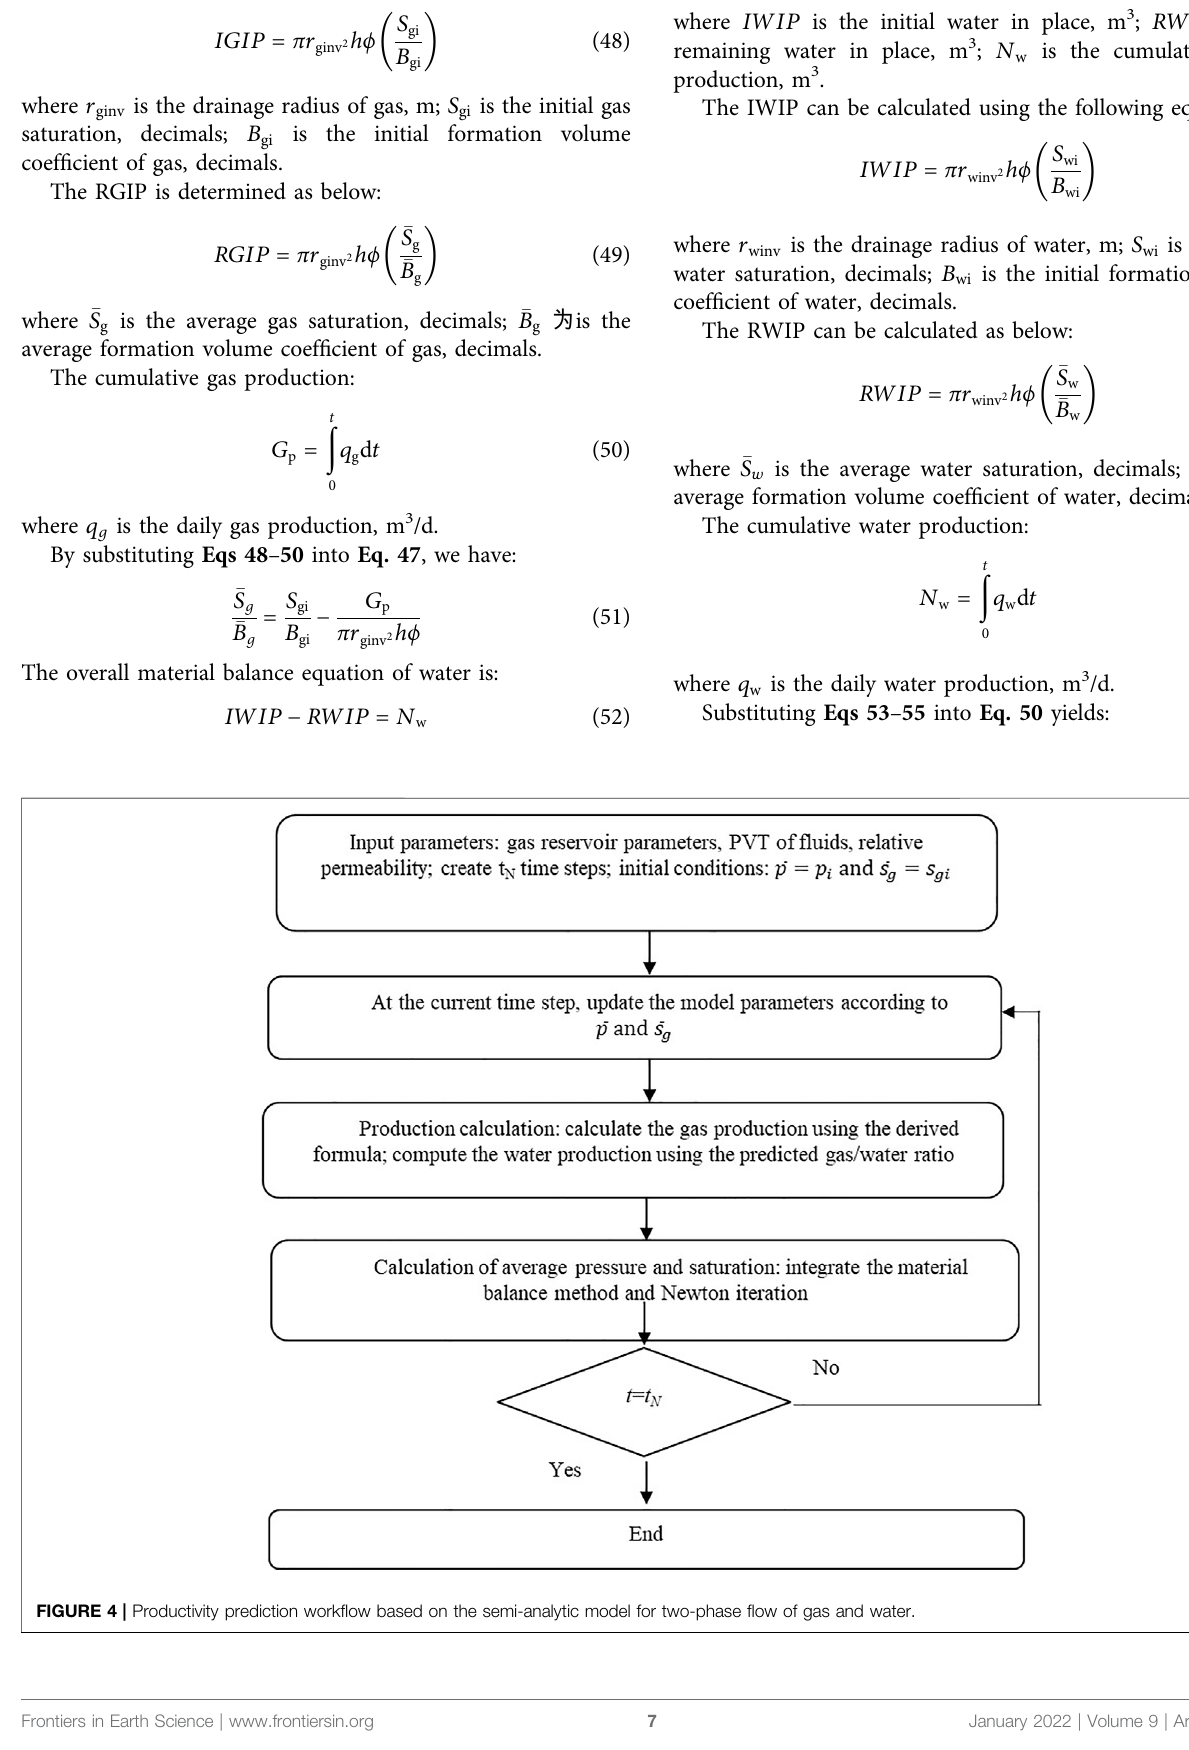
Frontiers in Earth Science |